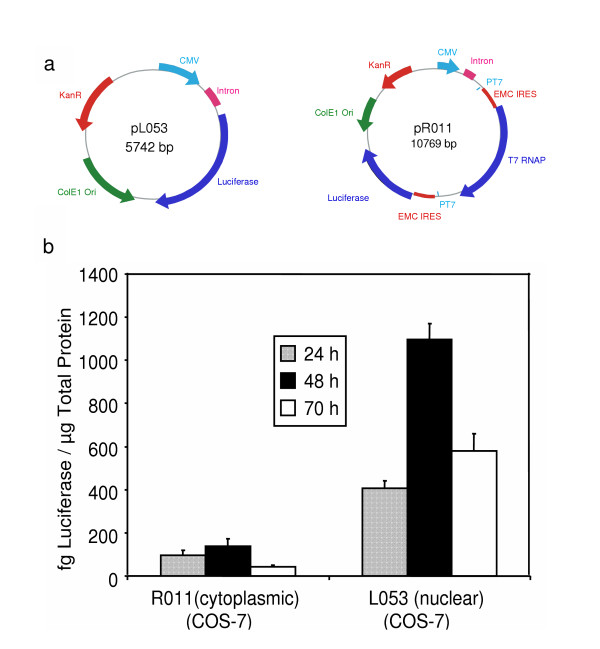
Autogene expression in COS-7 cells A) Diagrams of plasmids used. B) Comparison of cytoplasmic (R011) and nuclear (L053) expression plasmids in COS-7 cells. COS-7 cells were transfected with 0.75 μg/well of plasmid. Equimolar amounts of plasmids were added, and the total mass of DNA per transfection was kept equal by adding an unrelated plasmid (pPUC19). Transfections and luciferase assays were performed as described in Materials and Methods. Error bars indicate standard error.